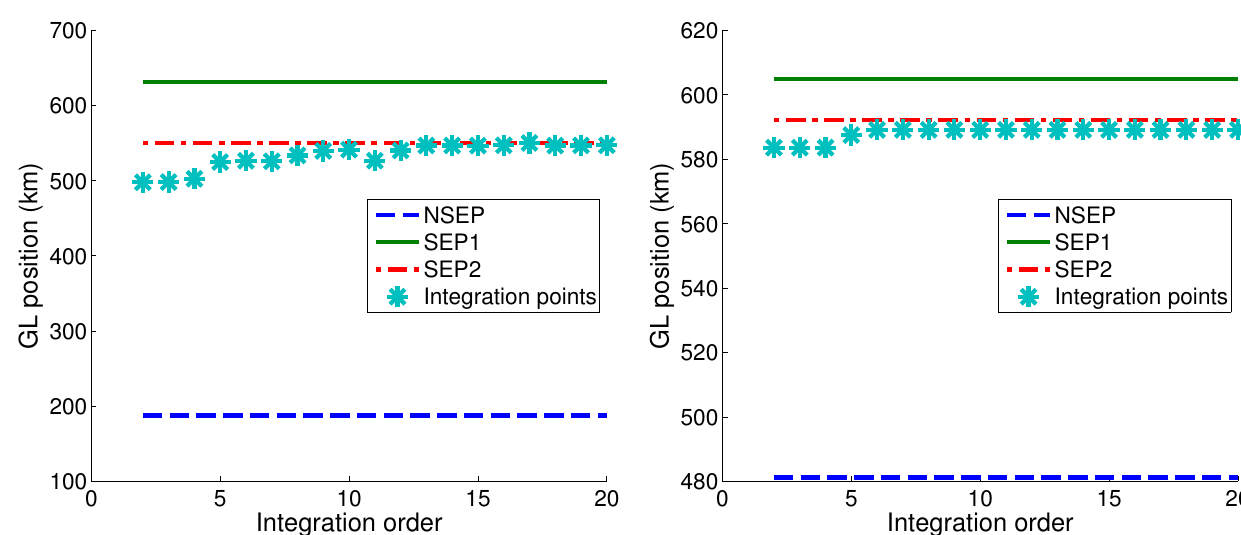
Figure 5. Grounding line position in y = 0 for 5km (left panel) and 1km (right panel) resolution mesh for NSEP (dark-blue dashed line), SEP1 (green straight line), SEP2 (red dash dotted line) and SEP3 with different integration orders (light blue stars).